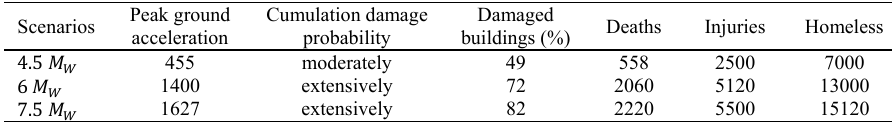
Table 1: Quick estimation of the number of casualties in Ray earthquake scenario